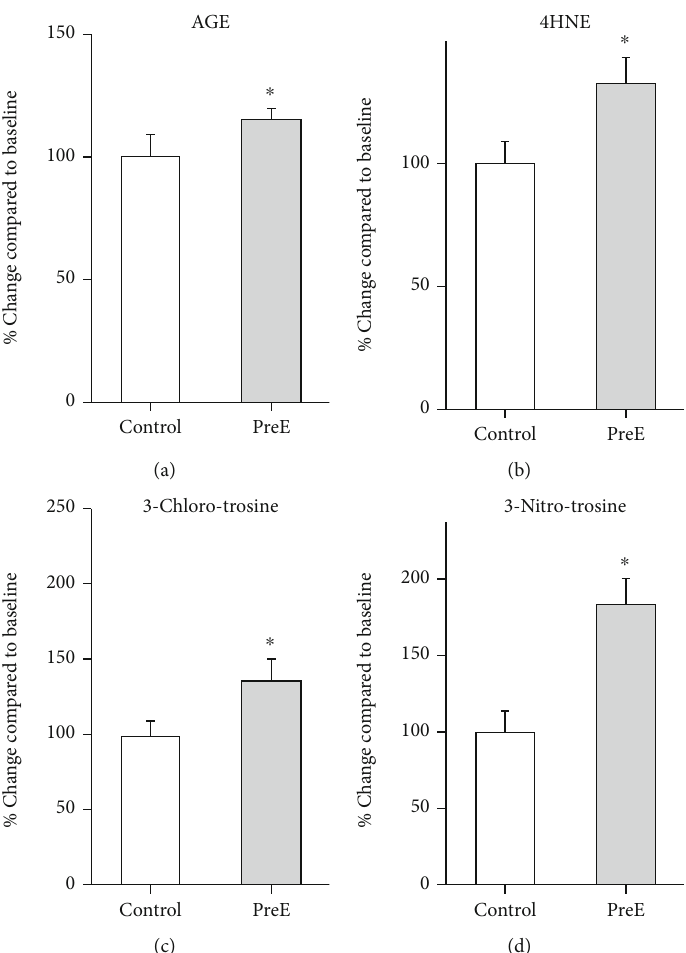
Figure 5: These oxidative adducts were increased in the pre-E placental sample. (a) AGE is signi fi cantly increased in late onset pre-E, (b) 4- HNE is signi fi cantly increased in late onset pre-E; (c) 3-chlorotyrosine was signi fi cantly increased in late onset pre-E; and (d) 3- Nitrotyrosine is signi fi cantly increased in late onset pre-E. ( p ≤ 0 : 05 , n = 4 (Figure 6(c)) (control: 100 % ± 10 : 2 , pre- E: 125 % ± 18 : 6 ). 670 nm light treatment decreased the num- ber of apoptotic HTR8/SVneo cells signi fi cantly (control: 50 % ± 24 : 2 , pre-E: 42 % ± 21 : 2 ).